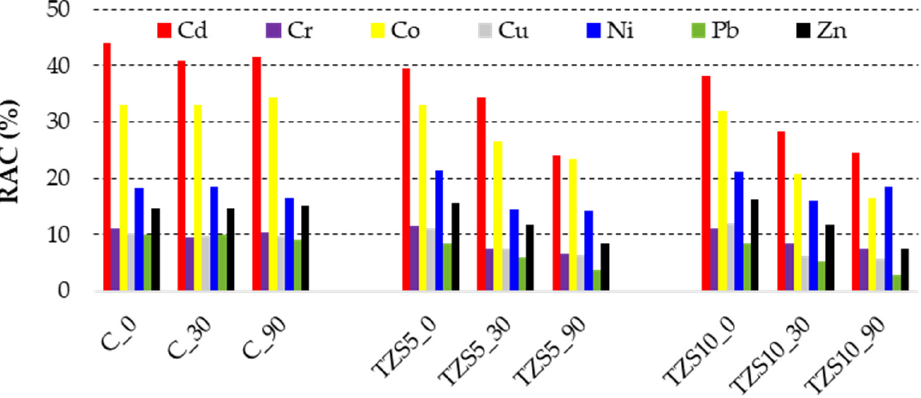
Figure 4. Risk assessment code (RAC) of potentially toxic elements in the control soil (C) and soil amended with 5% (TZS5) and 10% (TZS10) zeolite at 0, 30, and 90 days after